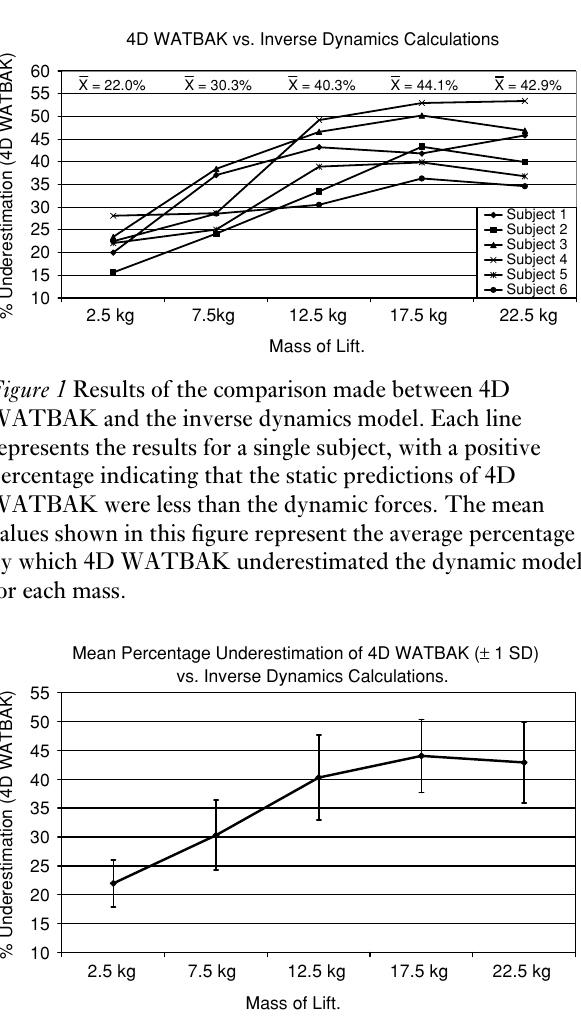
Figure 2 Mean percentage underestimation between 4D WATBAK and the inverse dynamics calculations, with ± 1 standard deviation bars shown. The graph clearly shows as the load increased, the percentage error also